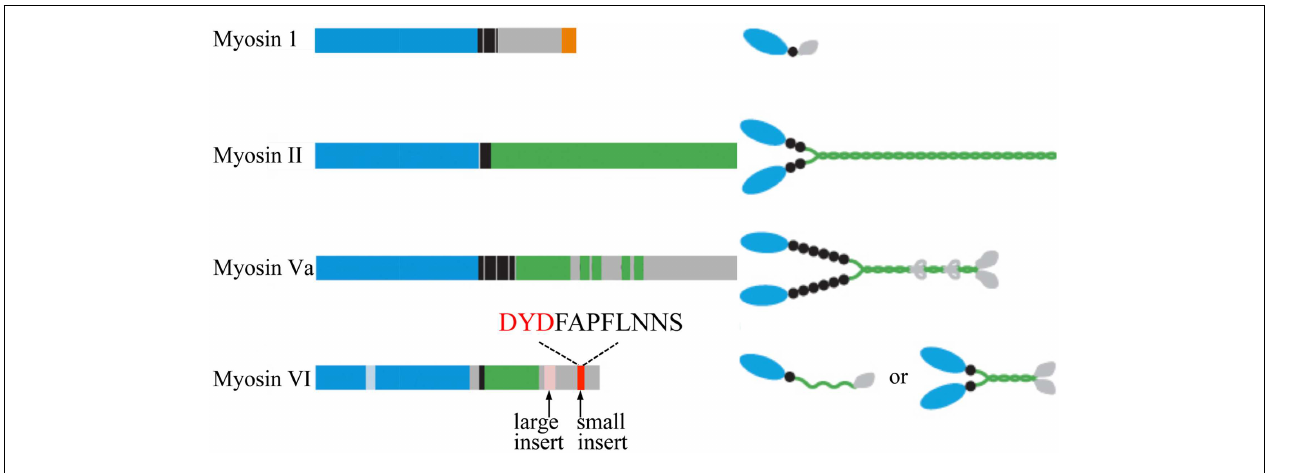
shown to be essential for the tethering of SGs to the cortical actin network, and the DYD-Src phosphorylation motif are highlighted. Cargo-binding induced dimerization of myosinVI is likely to be mediated by the coiled-coil regions and the cargo-binding domains. Adapted from Ref. (83).